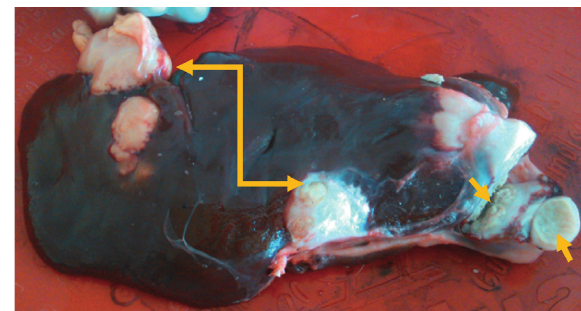
Figure 1: Gross characterization of hepatocellular carcinomas in a bull.